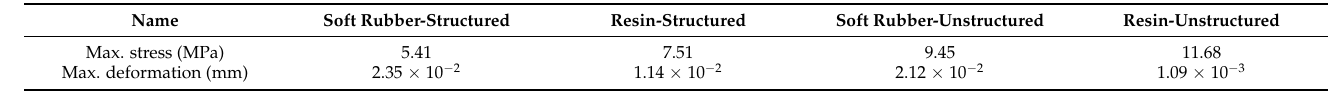
Table 3. Maximum principal stress and deformations of the four bionic pads under a 1500-N concentrated load in FE simulations.